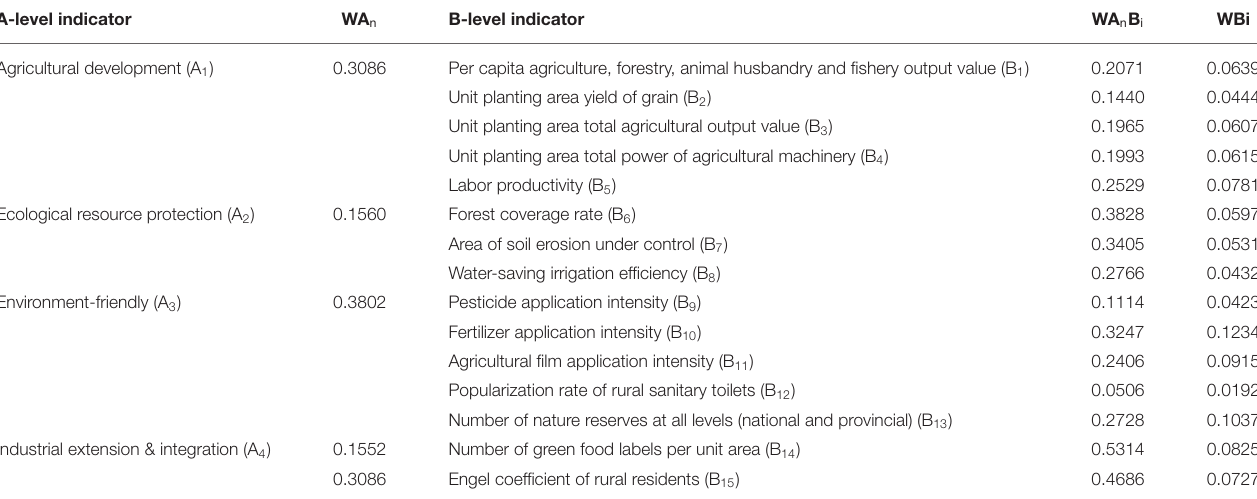
TABLE 3 | Index weights of each layer in the evaluation index system of agricultural green development level in the three northeastern provinces. A-level